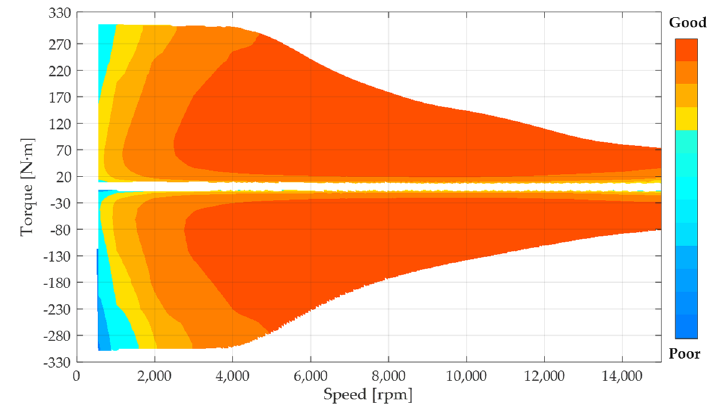
Figure 6. The efficiency map of generator electric drive system.